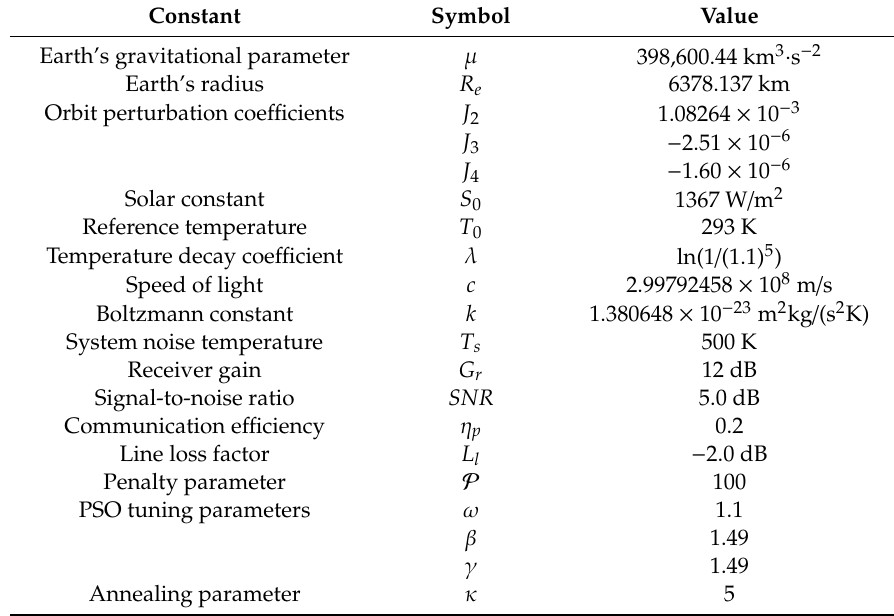
Table 2. Constants used in